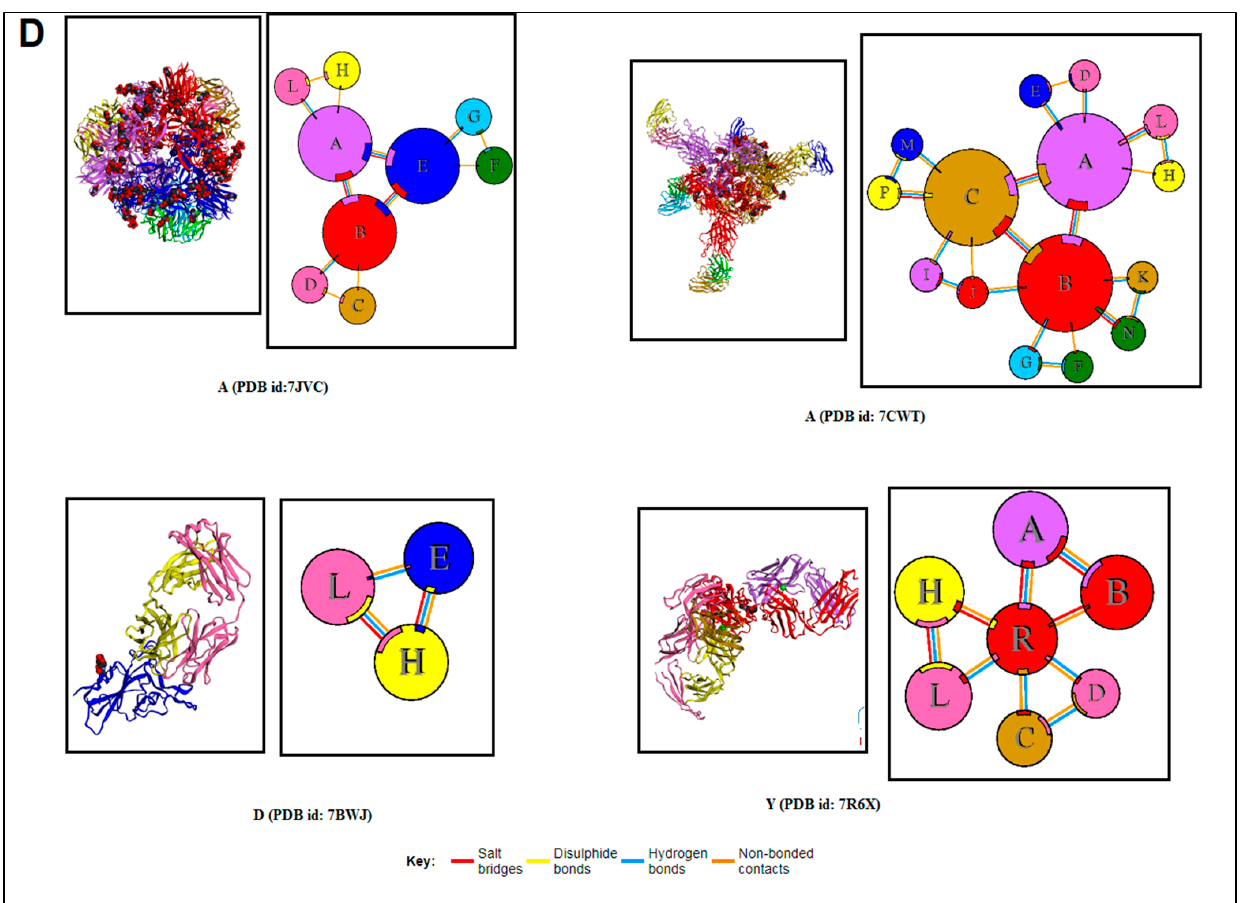
Figure 5. The schematic representation and study outcome of pattern recognition using protein– protein interface, inter-residue contact model, spring interaction/connection between the pair of interest nodes or chains and to develop a cross-correlation (CC) map, 2D map of communication/signaling sites and hitting/signal communication times, 2D map for the signaling rate, signaling receiving time, and signaling communication time of the SARS-CoV-2 proteins and non-SARS-CoV-2 proteins. ( A ) Schematic representation of pattern recognition using protein–protein interface 3D structures. ( B ) protein–protein interface 3D structures of each protein, which were used to develop the word “SARS-CoV-2”. ( C ) The protein–protein interface 3D structures of each protein, which were used to create the word “COVID-19”. ( D ) The protein–protein interface 3D structures of our SARS-CoV-2 protein alphabets with antibodies/immunological or vaccine-associated roles used in this study. The study (Figure 5A–D) tried to analyze the structural pattern of 3D forms of each protein and their assemblies through the protein–protein interface.